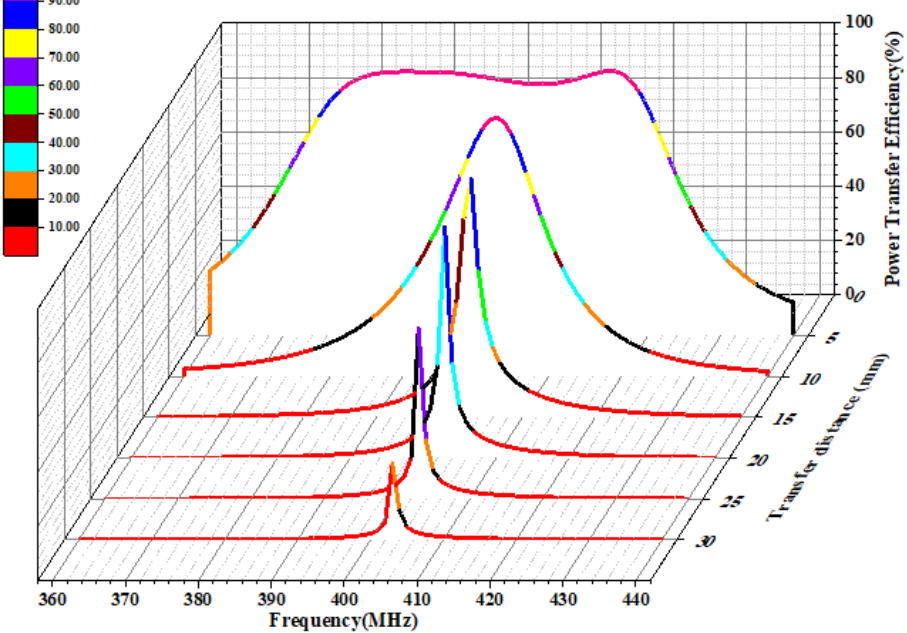
Figure 11. Simulated PTE at different transfer distance by using four-turn planar split-ring loops.